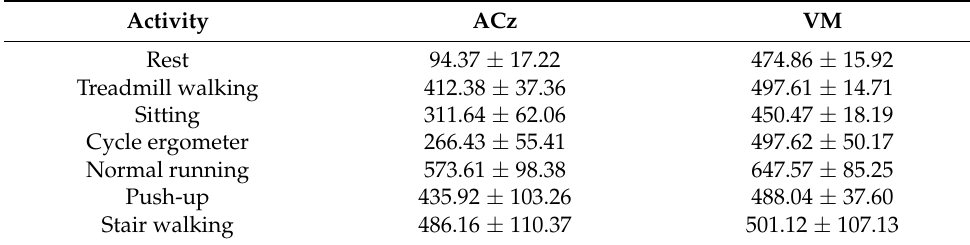
Figure 1. Standardized data obtained from SenseWear Pro3 Armband™, three different types of curves marked the seven tested activities, triaxial acceleration data indicated with forward accel-point, transverse accel point, and longitudinal accel point. Table 3. Acceleration values of seven activities (mean ±